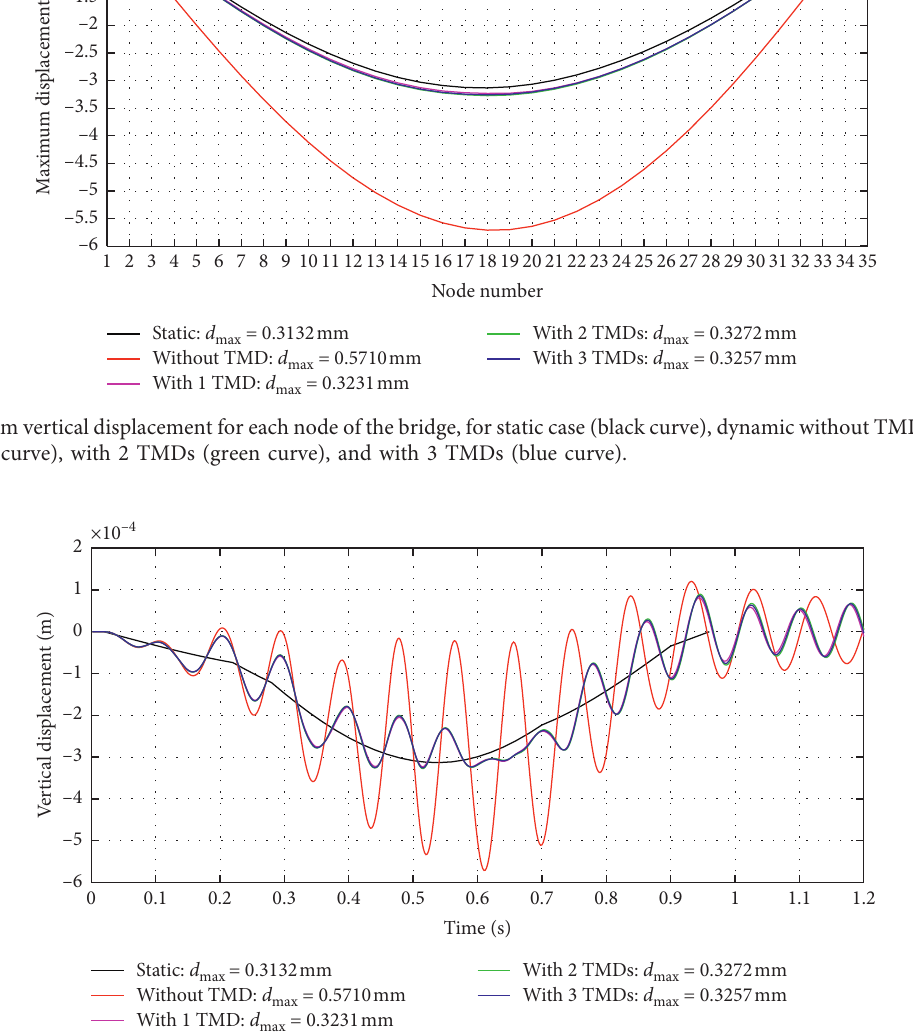
Figure 9: Vertical displacement at the bridge central node (node 18), as the vehicle moves along the bridge, for static case (black curve), dynamic without TMD (red curve), with 1 TMD (magenta curve), with 2 TMDs (green curve), and with 3 TMDs (blue